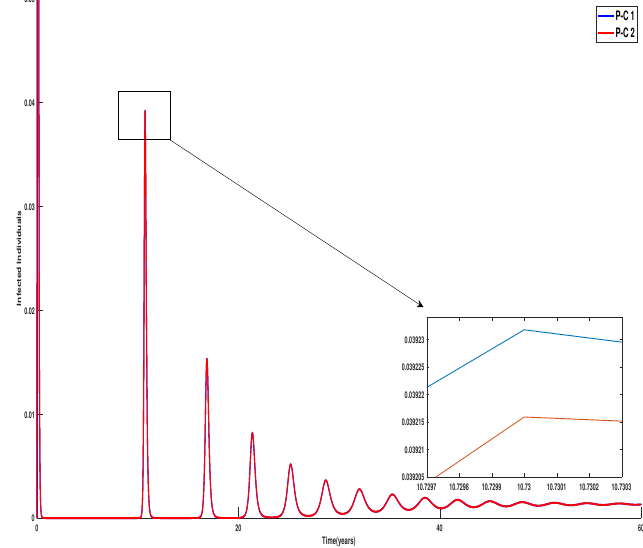
Figure 4. The numerical results of system (2) using the P-C 1 schemes and P-C 2 schemes with h = 0.01 following parameter values ( R 0 > 1 ) and I.C. S 0 = 0.9, I 0 = 0.05, R 0 = 0.05, β = 123, µ = 0.04, ν =